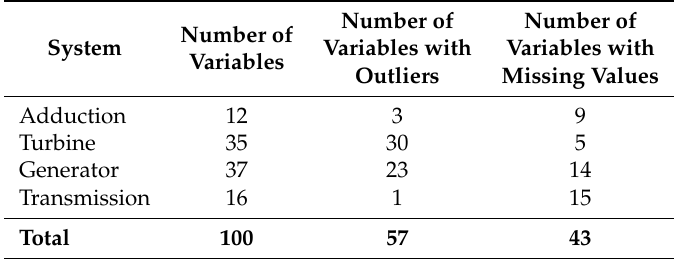
Table 1. Distribution of variables among the operation subsystems and number of anomalies. Number of Number of Variables with System Variables